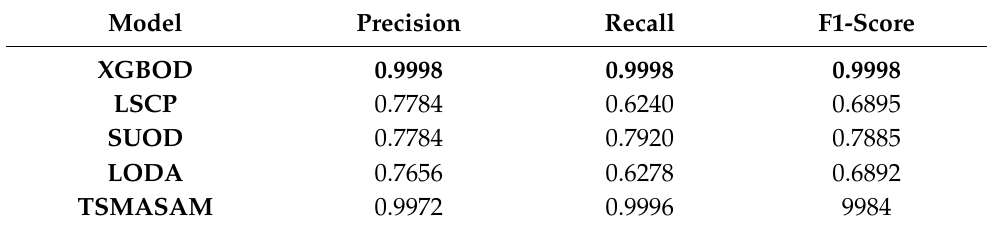
Table 2. Comparative experiment between TSMASAM and the anomaly detection algorithm based on ensemble